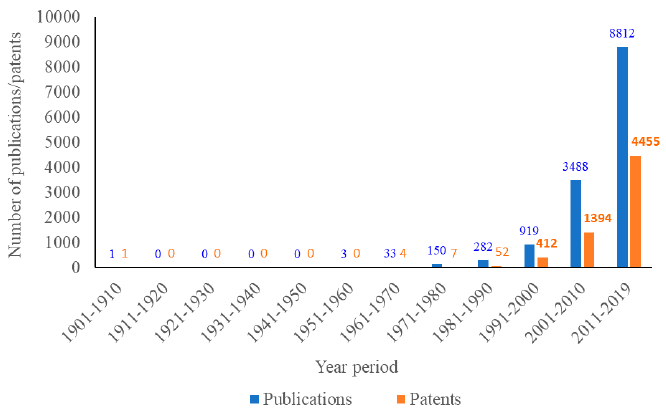
Figure 1. Number of scientific outputs containing the word “propolis” per decade